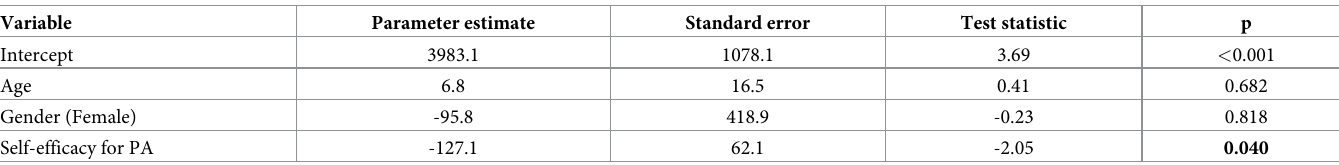
Table 5. Regression model results with energy intake as dependent variable and self-efficacy for Physical Activity (PA), gender, and age as explanatory variables.